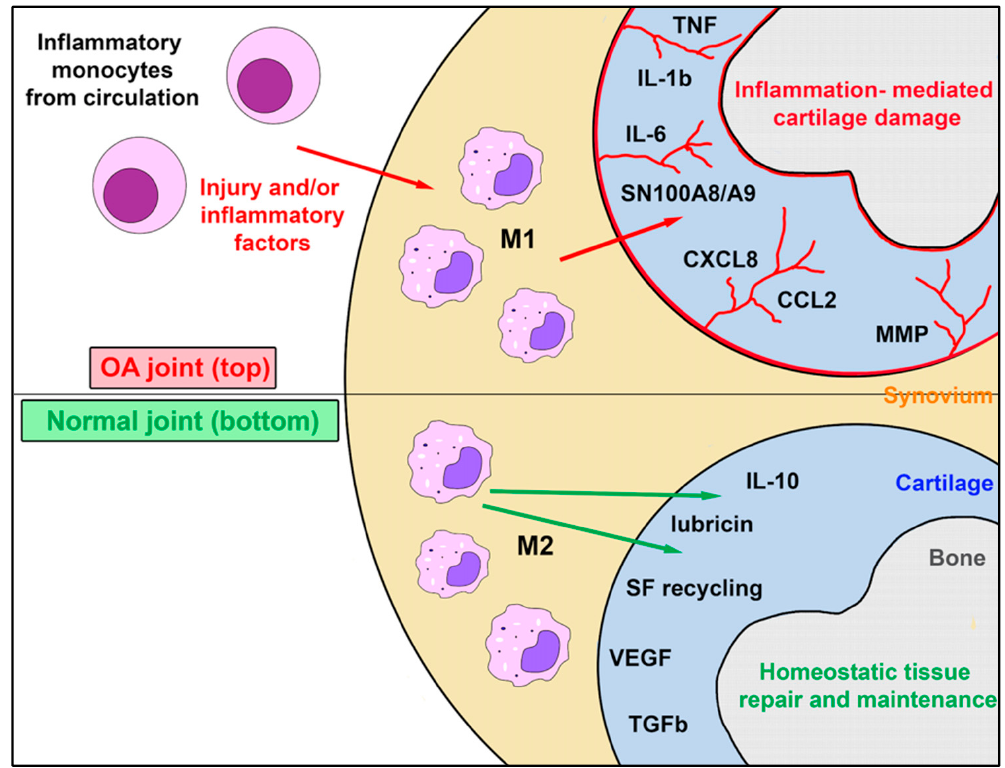
Figure 1. Role of synovial resident macrophages and inflammatory macrophages in joint health and osteoarthritis. This figure illustrates the complex interaction between endogenous self-renewing synovial cell macrophages, which exist as M2 cells in the healthy joint, and the inflammatory macrophage M1 population recruited from inflammatory monocytes in blood in response to chemokines produced during joint inflammation occurring during the progression of OA. While M1 macrophages may assume an M2 phenotype as inflammation subsides, endogenous M2 macrophages typically do not generate M1 macrophages. The factors secreted by synovial M1 and M2 macrophage populations in health and disease are complex and largely distinct. Abbreviations: tumor necrosis factor (TNF); interleukin 1B (IL-1B); interleukin 6 (IL-6), Myeloid protein SN100A8/A9; C-X-C Motif Chemokine Ligand 8 or Interleukin-8 (CXCL8); (CCL2); matrix metalloproteinase (MMP); interleukin 10 (IL-10); synovial fluid (SF); vascular endothelial growth factor (VEGF); transforming growth factor B (TGF-B).